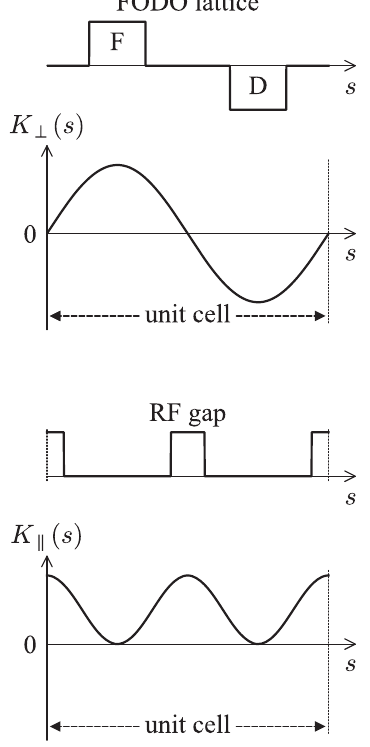
FIG. 1. Sinusoidal focusing